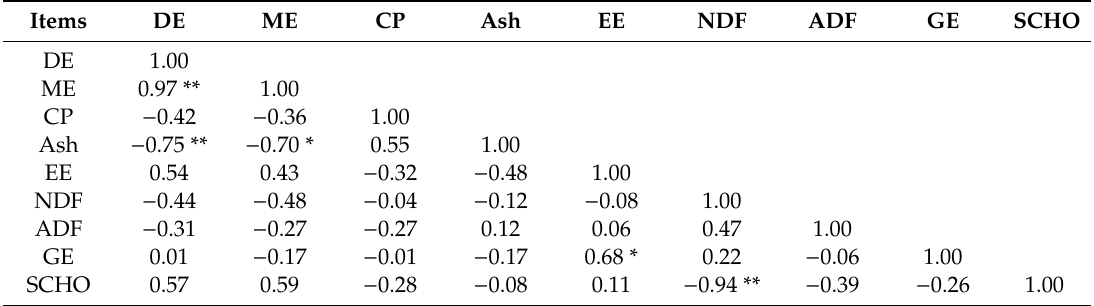
Table 8. Correlation coe ffi cients among chemical compositions and energy in the soybean meal 1